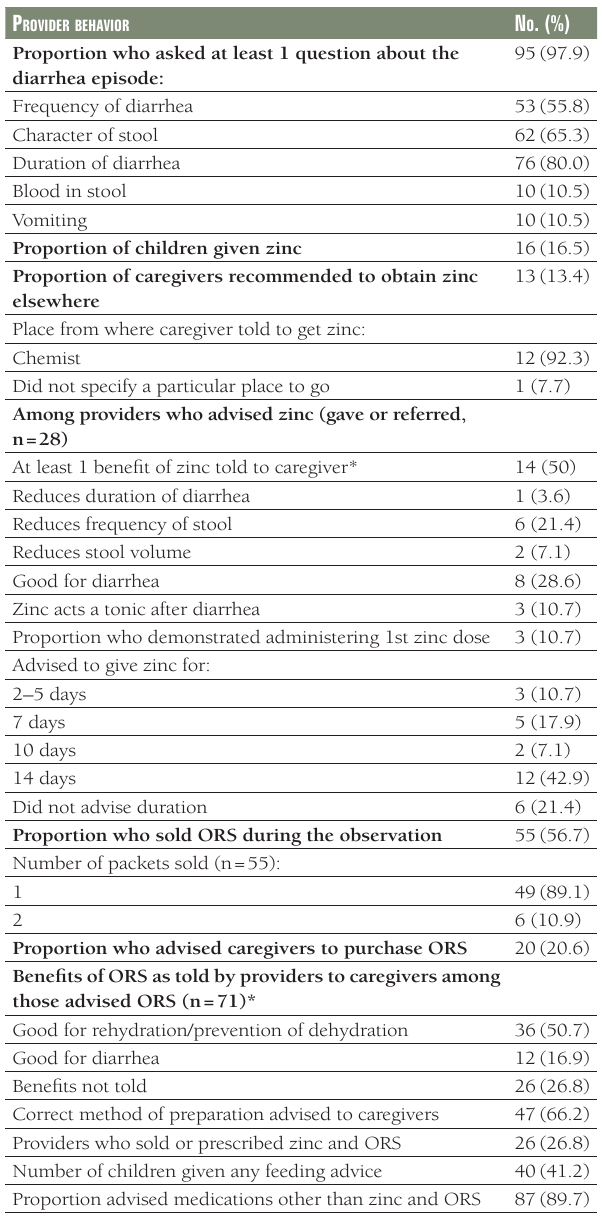
Table 3. Treatment behaviors of private providers observed during the treatment of a child 2–59 months of age